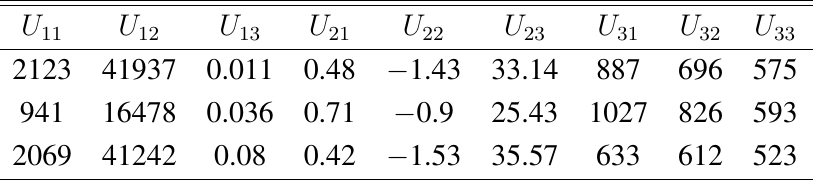
Features of three classes (X1L, B4L and S1) of the standard specimen tobacco